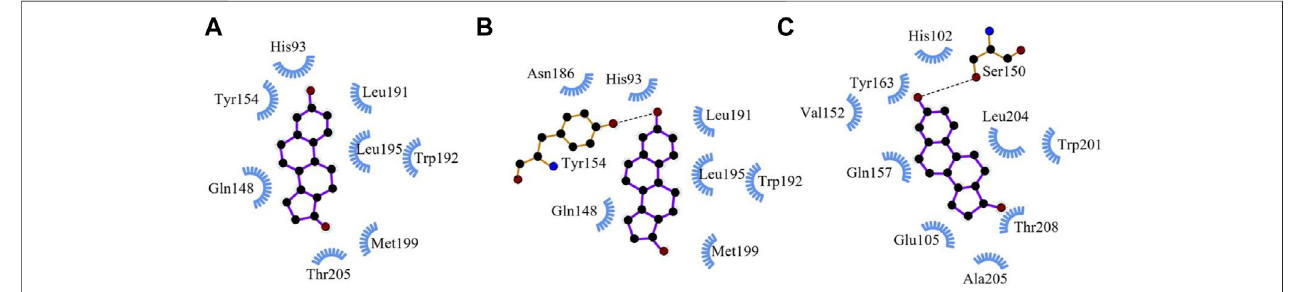
FIGURE 5 | Comparison of the docking poses of 17§HSD14 with similar ligands generated using LigPlot + v1.4 software (Laskowski and Swindells 2011). Circled residues indicate side chains that are involved in docking for at least two of the three models. (A) crystal structure of estrone bound to human 17§HSD14 (5HS6). (B) crystal structure of human 17bHSD14 docked to estradiol. (C) crystal structure of Exaiptasia l7§HSD14 docked to estradiol.